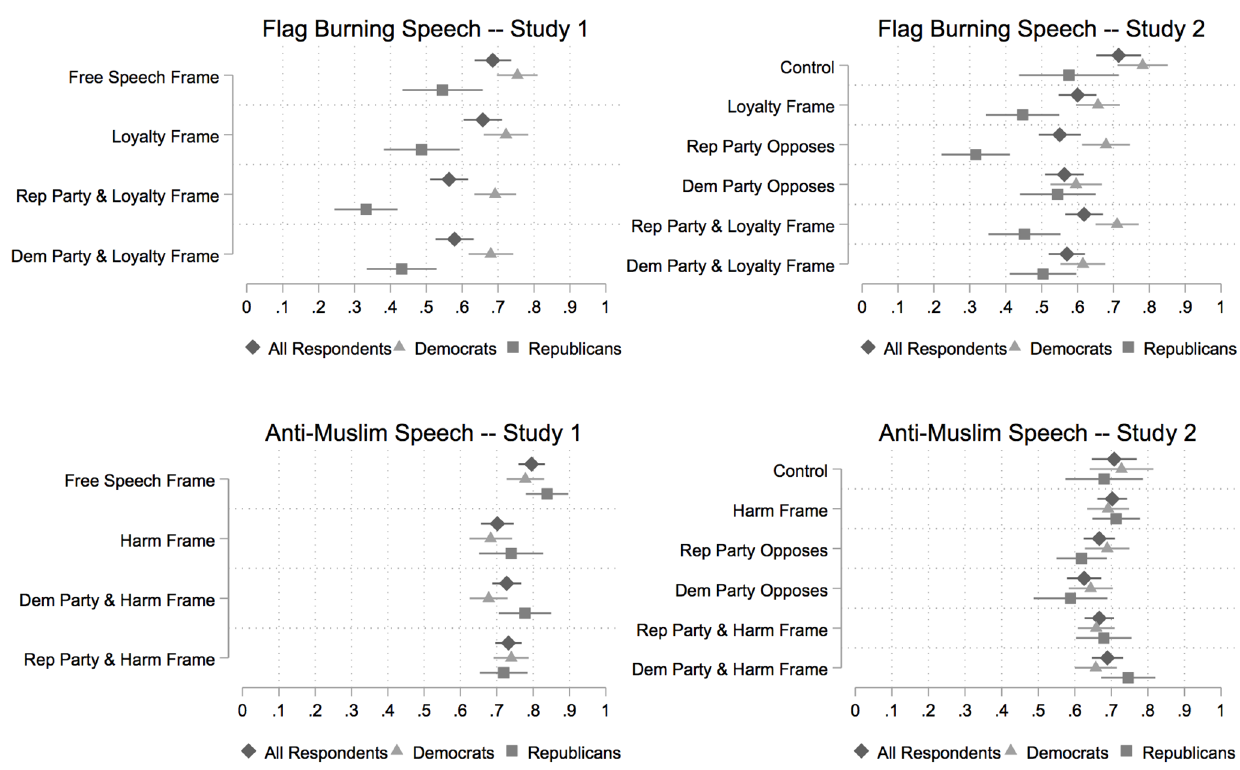
Figure 1. Mean tolerance of hateful speech by condition. Note. In Study 2, the non-political control condition is split into two, where respondents who answered the flag burning item first comprise the flag burning control condition, and respondents who answered the anti-Muslim item first become the anti-Muslim control